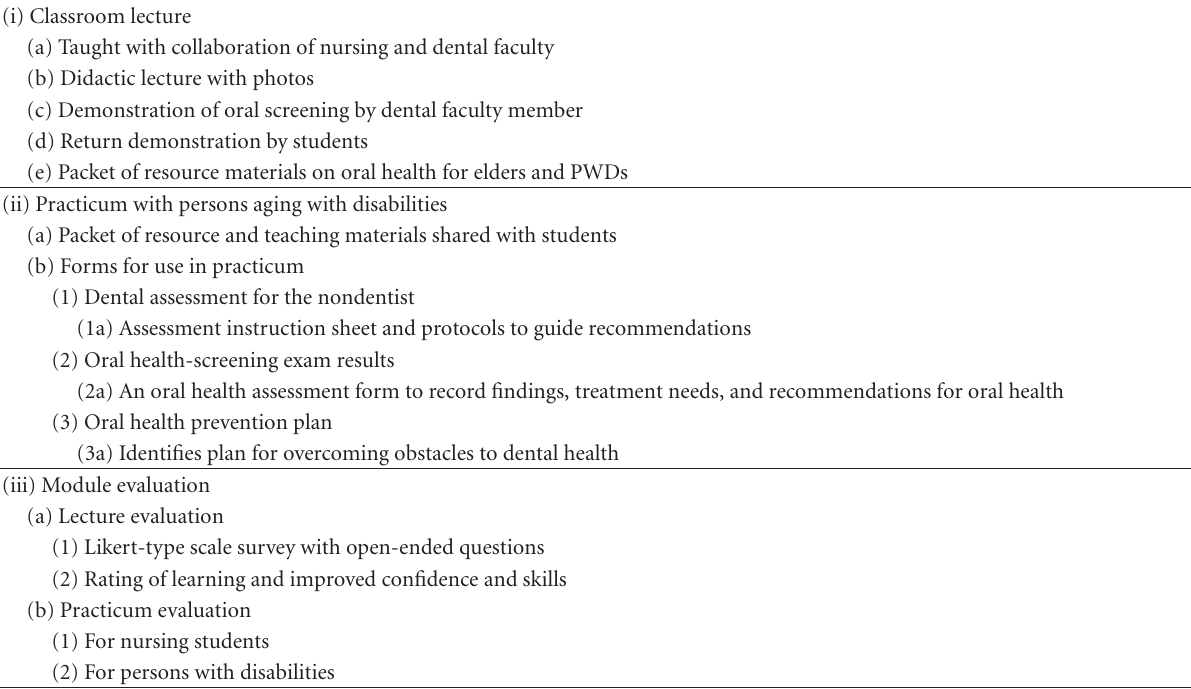
Table 2: Components of oral health